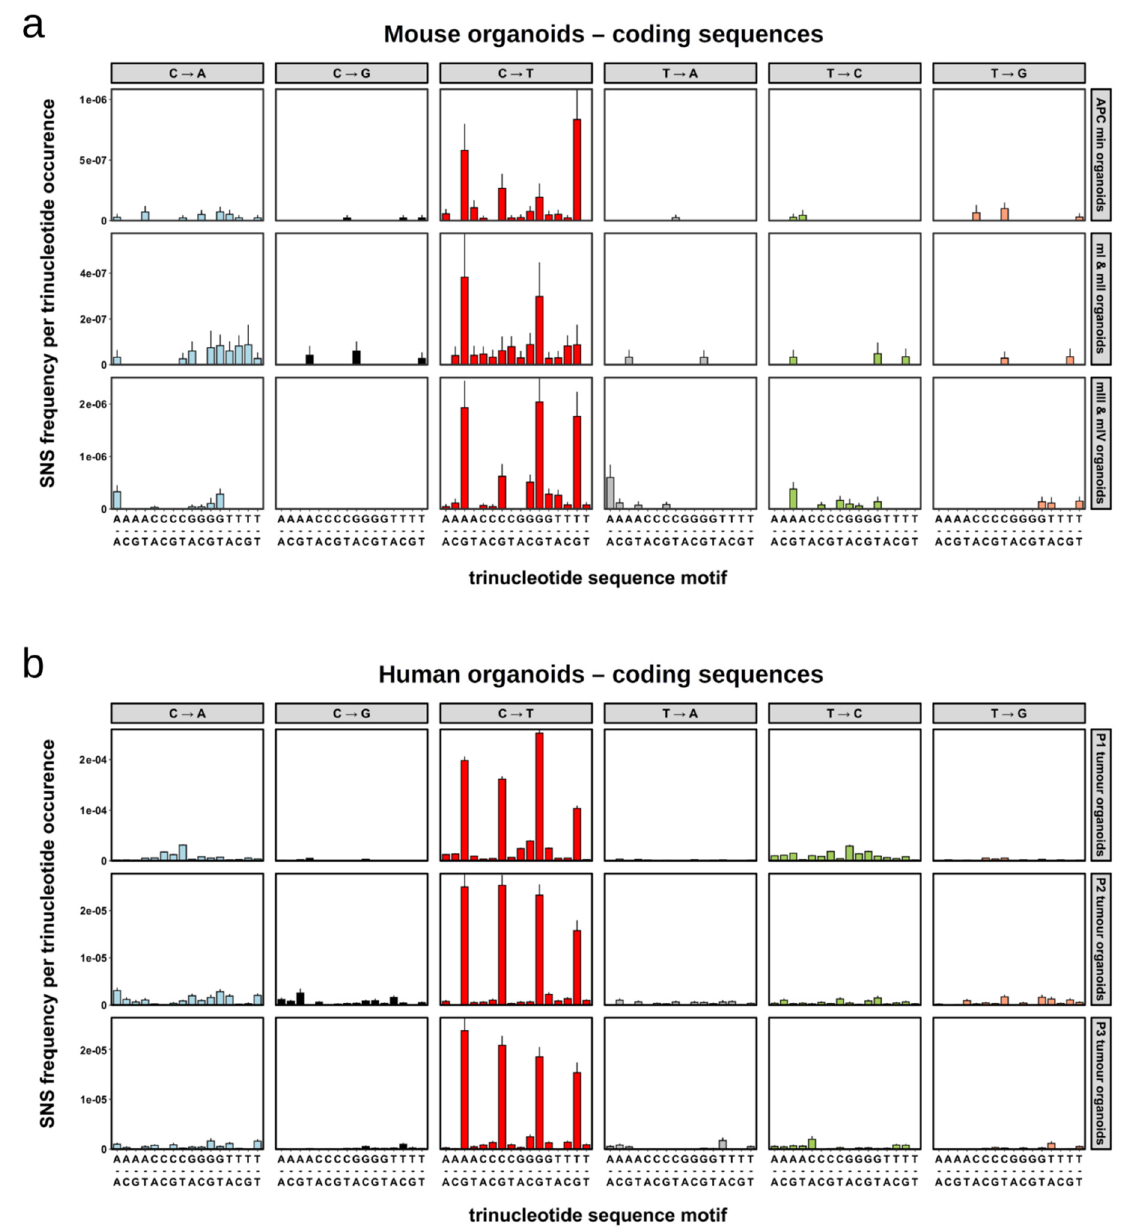
Figure 4. Mutational signatures of somatic SNSs in tumour organoids. ( a ) Normalised signatures of protein-coding SNSs identified in the tumour organoids from mice I-IV of this study and from Apc min/+ mice. ( b ) Normalised signatures of protein-coding SNSs identified in the tumour organoids from three CRC patients. The SNS frequencies were normalised according to the prevalence of the respective nucleotide triplets in the protein-coding sequences of the mouse ( a ) and human ( b ) reference genomes.